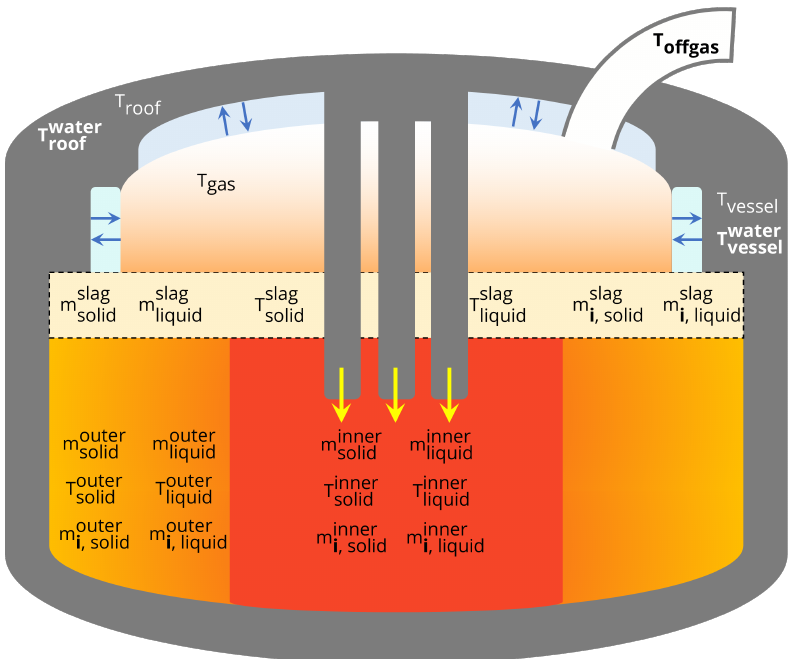
Figure 1. State variables in the EAF process model. T water real-time process data. Table 1. Modeled components in the steel and slag phases. Dissolved Phase(s) Reactive with O 2 in Model? Component